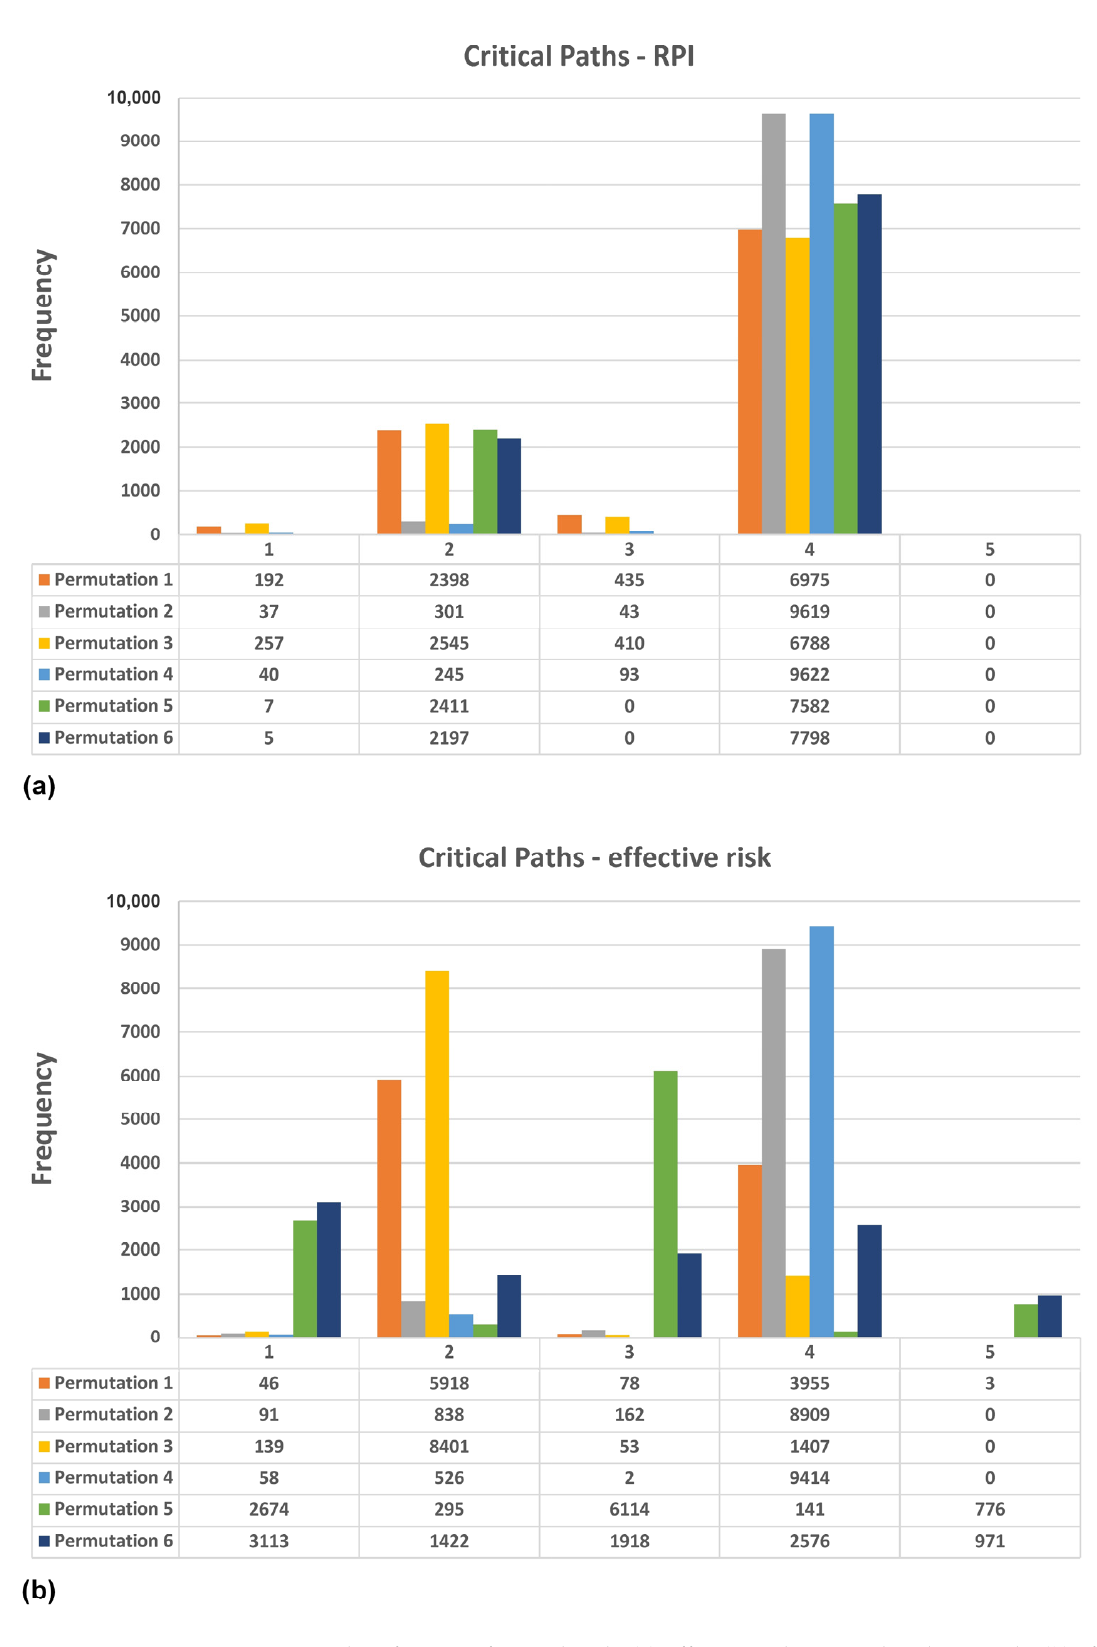
Figure 11. Identification of critical path. ( a ) Effective risk assessed with RPI only, ( b ) effective risk assessed with RPI together with QMI.